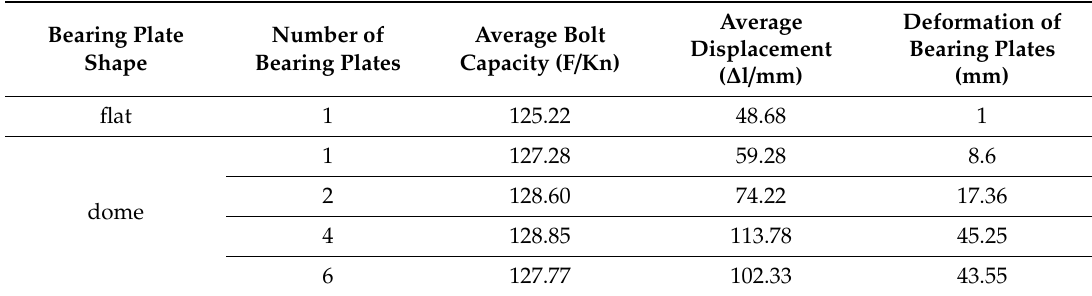
Figure 12. Load–displacement characteristics of a 1.6 long rock bolt support equipped with the sleeve mechanical head with bearing plate: ( a ) flat; ( b ) dome; ( c ) two domes; ( d ) four domes; ( e ) six domes. Table 1. Average displacement and load values of the 1.6 m-long rock bolt support equipped with the sleeve mechanical head.